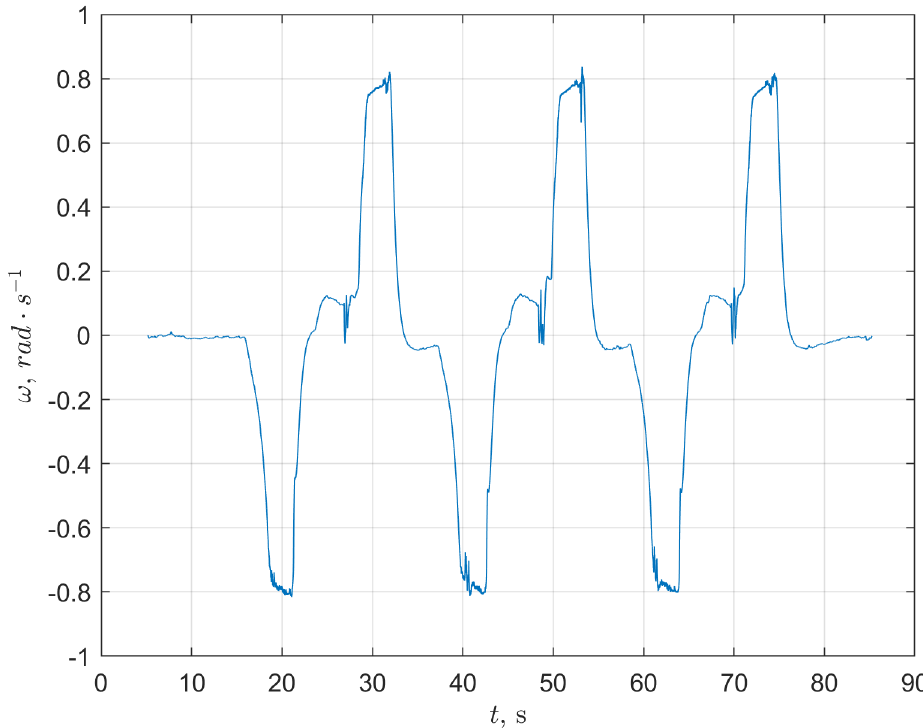
Figure 9. Changes in angular rate over time for the lowest value of the cost function equal to 1—track 1).